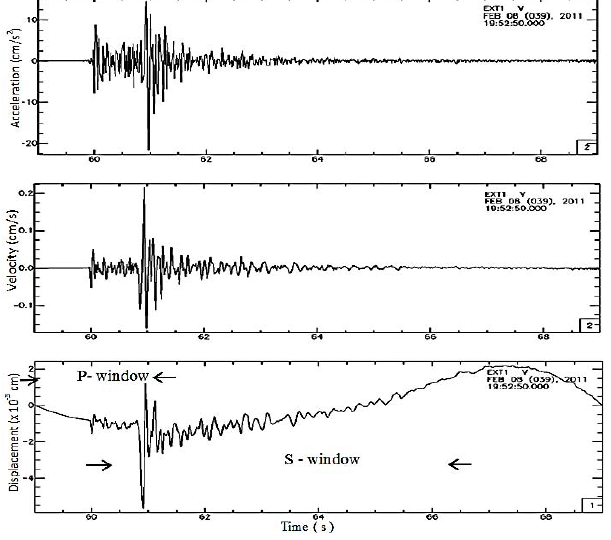
Fig. 5. Acceleration, velocity and displacement signal from the largest earthquake in Peñamiller that occurred on 8 February 2011 at 19:53:48.60 UTC are shown. Long of each phase-window on dis- placement signal for the spectral analysis are indicated with arrows. Note: although P-window includes some of the S phase, this is elim- inated by the taper, which diminishes the effects of the window ex- tremes.